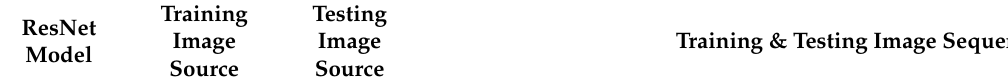
Table 3. Accuracy and area under the receiver operating characteristic curve for models trained on and tested with the entire ProstateX-2, local institutional, and combined ProstateX-2 and local institutional image data using 5-fold cross-validation. t -tests compared the AUC and accuracies of models trained and tested using the same image data source (labeled *) to those using different training and testing sources (labeled †). Statistically significant differences ( p < 0.01) shown by 2-tailed t -test are underlined. PX2: ProstateX-2 data, Local: local institutional data, PXL: combined prostateX-2 and local institutional